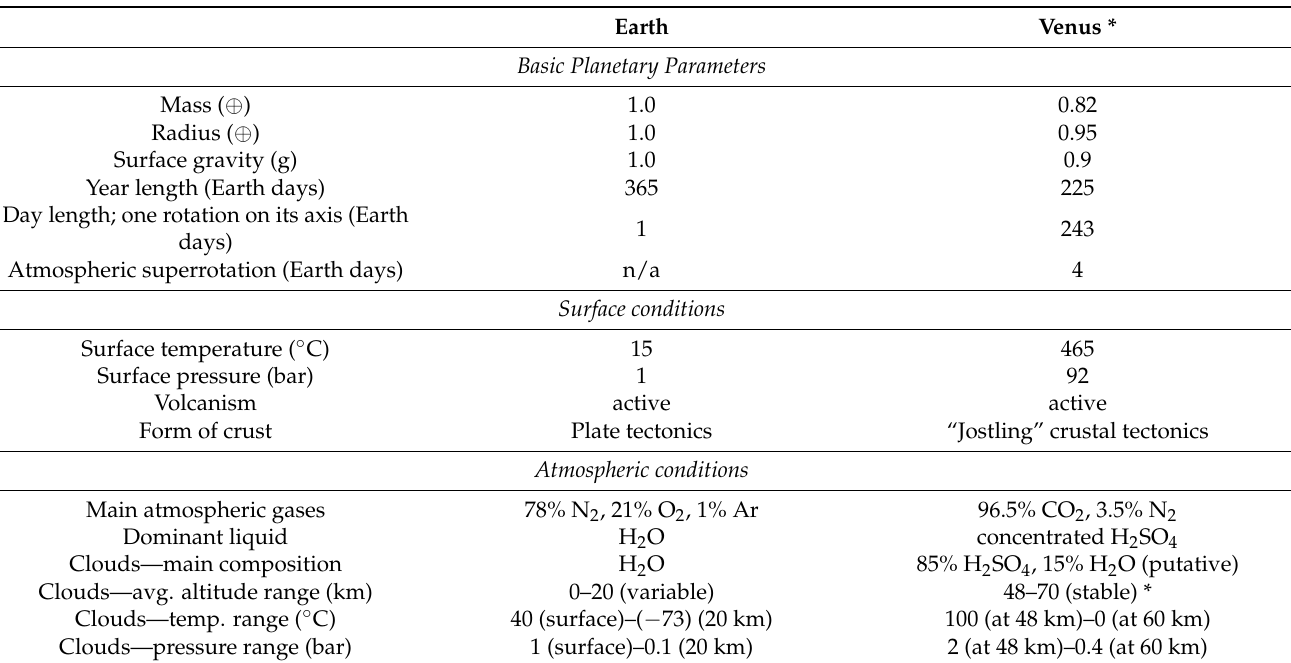
Table 1. Earth and Venus at a glance. The basic characteristics of both planets compiled based on [42–51]. Earth Venus * Basic Planetary